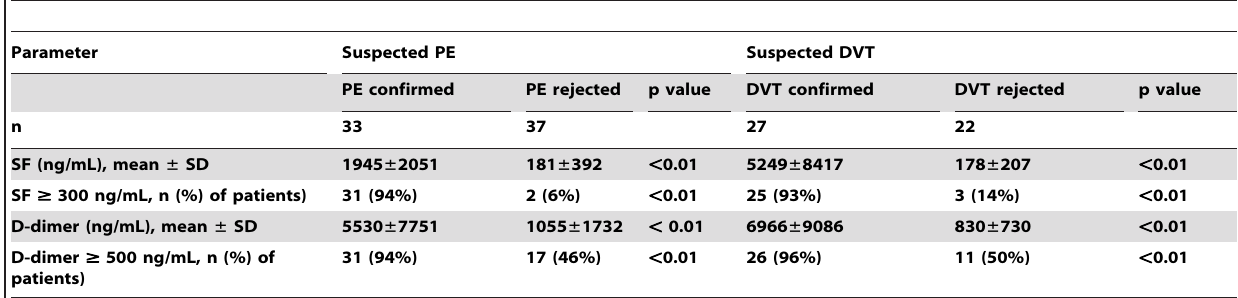
Table 3. Plasma Soluble Fibrin (SF) and D-dimer levels in Patients with suspected Pulmonary Embolism (PE) or Deep Vein Thrombosis (DVT).